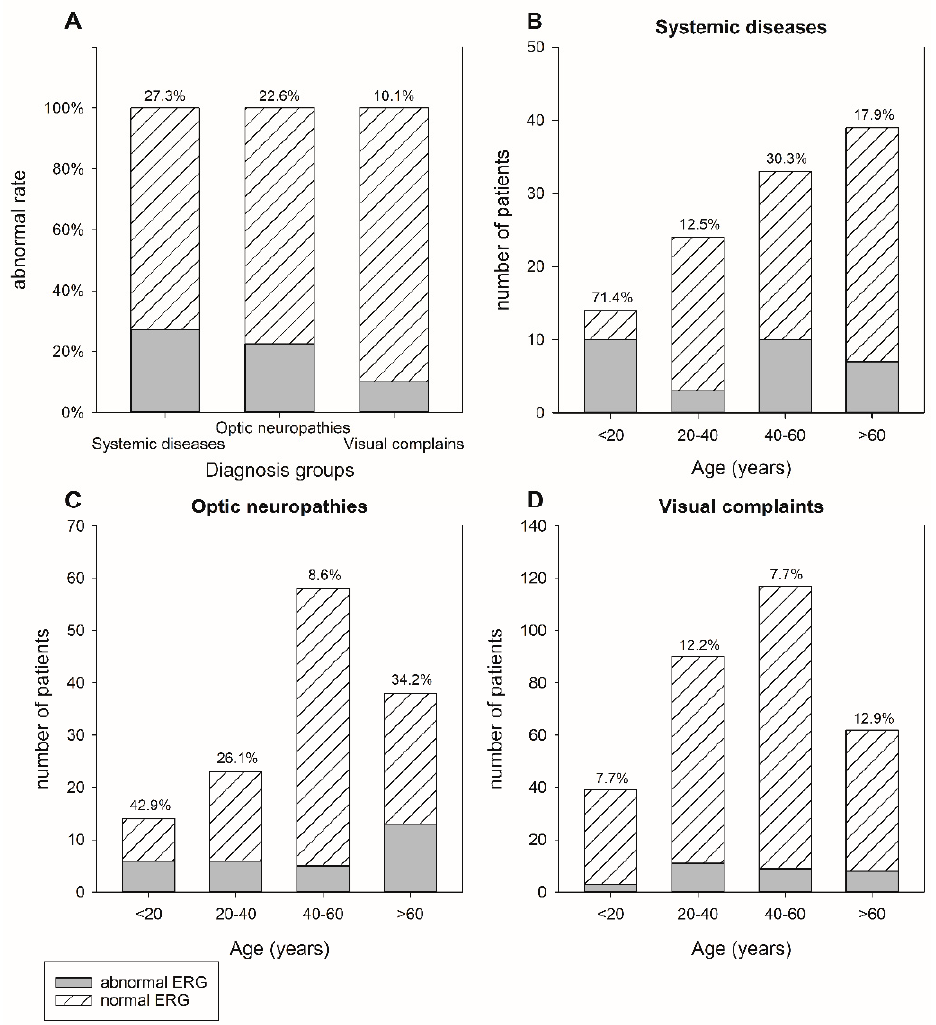
Figure 3. ( A ) Rates of abnormal ffERG examination results in the ‘systemic diseases’, ‘optic neu- ropathies’, and ‘visual complaints’ groups. ( B – D ) Rates of abnormal ffERG examination results and the age distribution of patients in the ‘systemic diseases’, ‘optic neuropathies’, and ‘visual complaints’ groups, respectively, when receiving their first